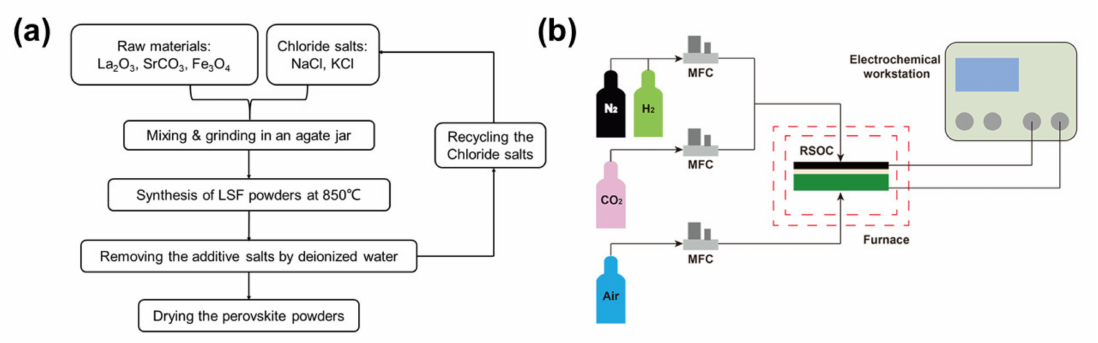
Figure 1. Schematic diagrams of molten salt synthesis procedures of La 0.6 Sr 0.4 FeO 3 − δ (LSF) powders ( a ) and the button cell test apparatus ( b